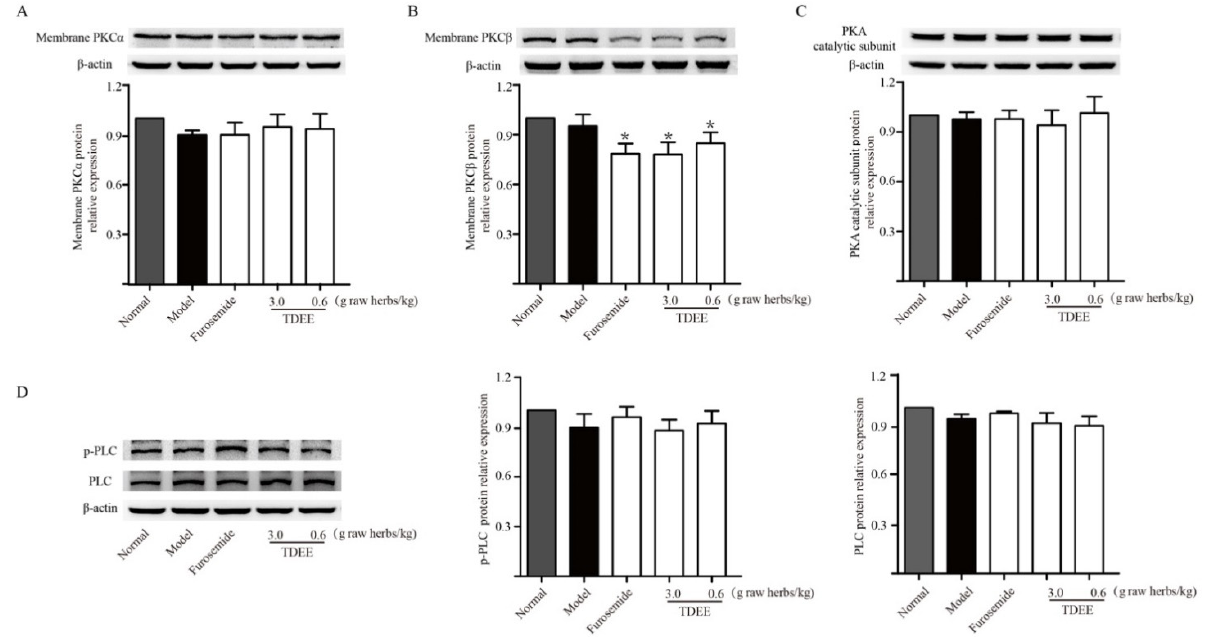
Figure 4. Effects of total diterpenoids from the root of Euphorbia ebracteolata Hayata (TDEE) on protein kinase C (PKC) and protein kinase A (PKA) activation in the kidneys of H22 tumor cell-bearing mice. ( A ) Western blot band and protein relative expression of PKC α . ( B ) Western blot band and protein relative expression of PKC β . ( C ) Western blot band and protein relative expression of PKA. ( D ) Western blot bands and protein relative expression of phospholipase C (PLC) and phosphorylated PLC. Normal: normal mice treated with blank solvent. Model: H22 tumor cell-bearing mice treated with blank solvent. The data are represented as the mean ± SD, n = 3, * p < 0.05 vs. model group (Mann–Whitney U test).